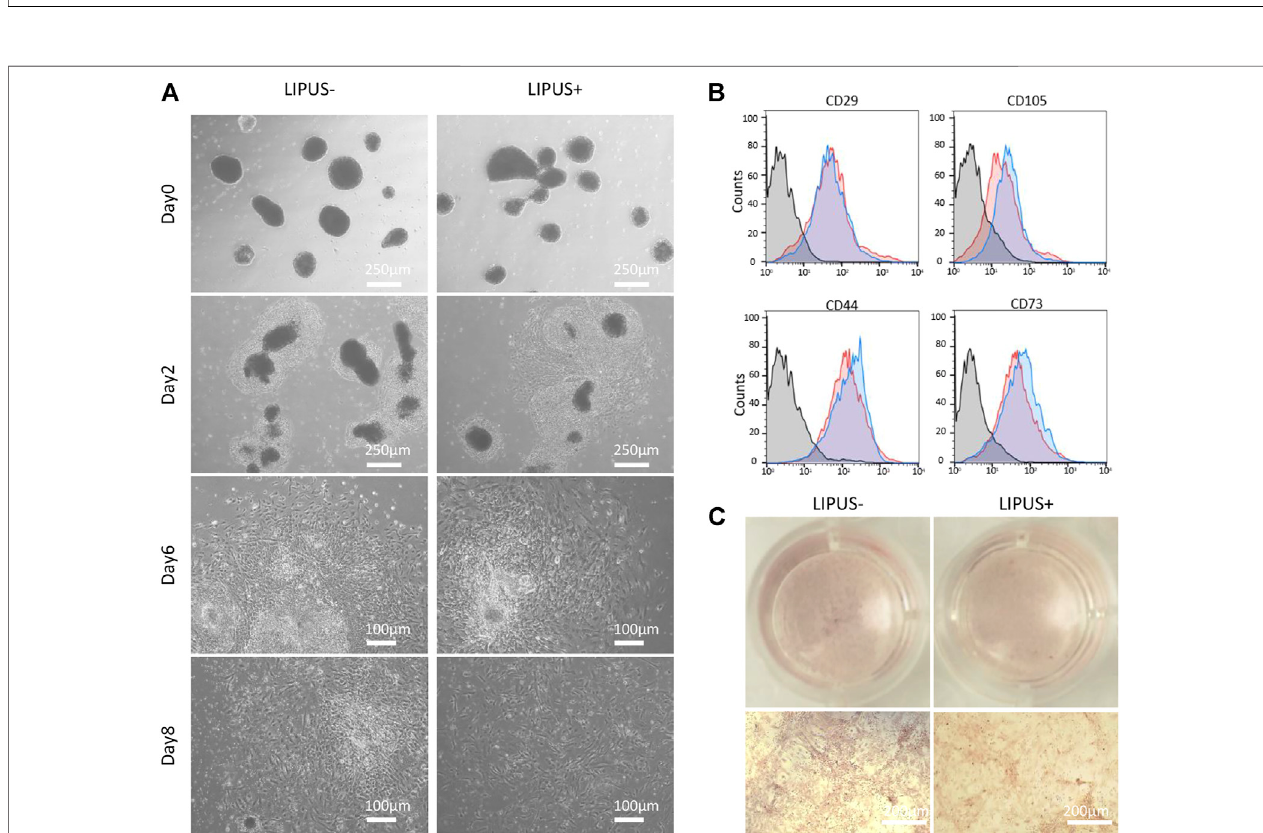
Frontiers in Bioengineering and Biotechnology |